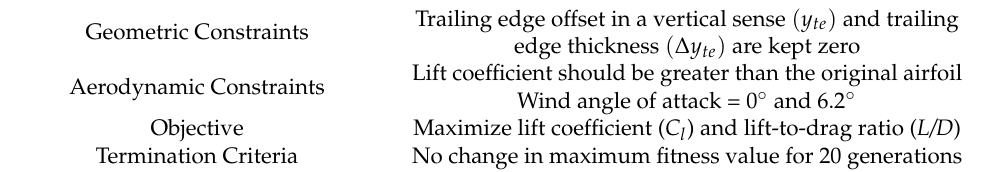
Table 2. Optimization criteria and constraints.